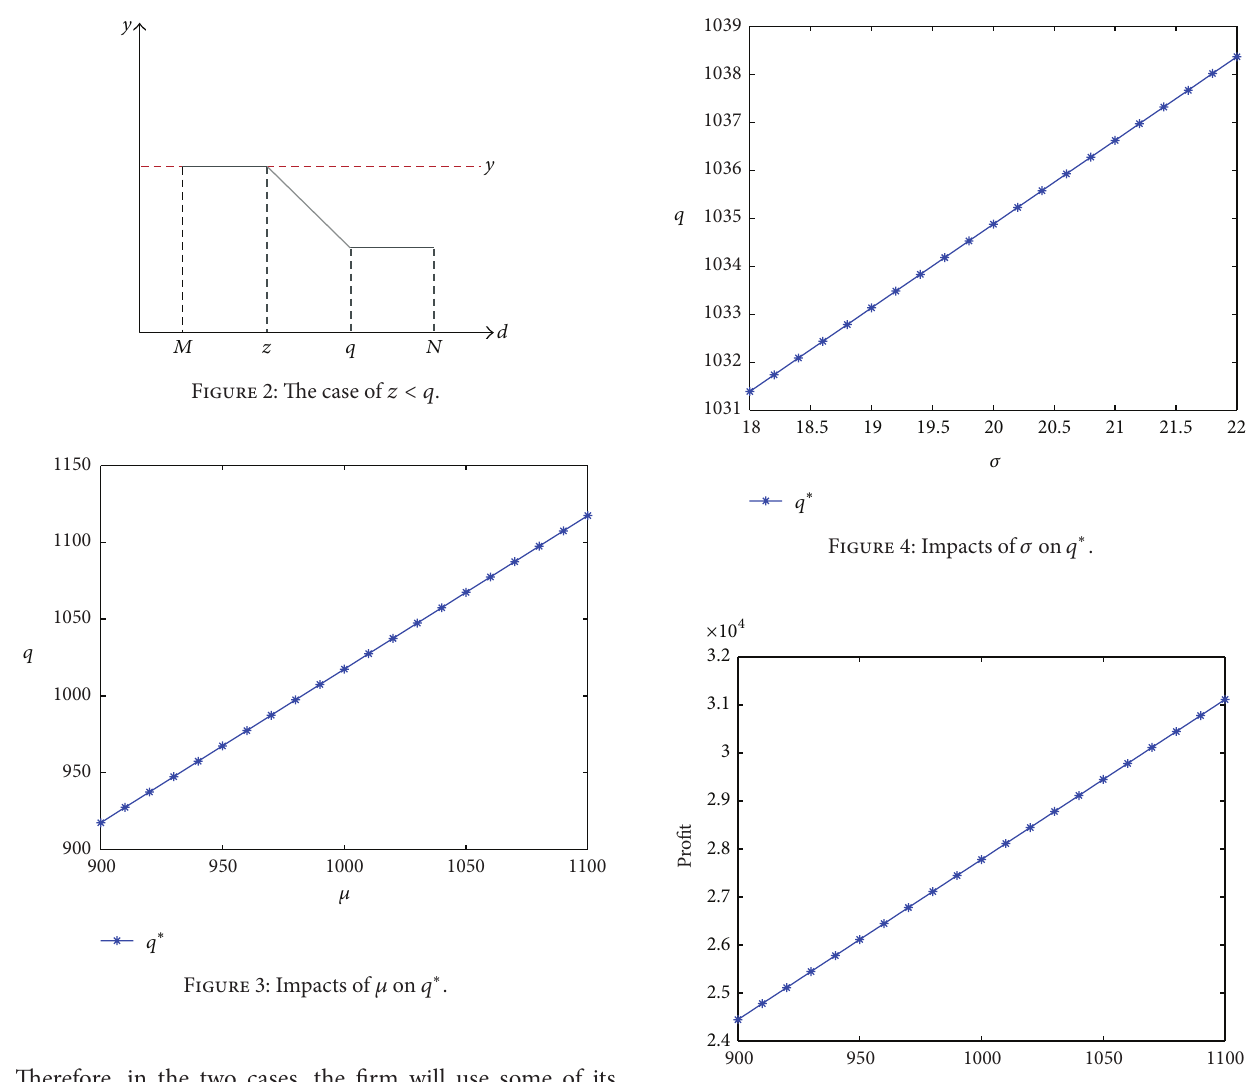
Figure 3: Impacts of 𝜇 on 𝑞 ∗ .